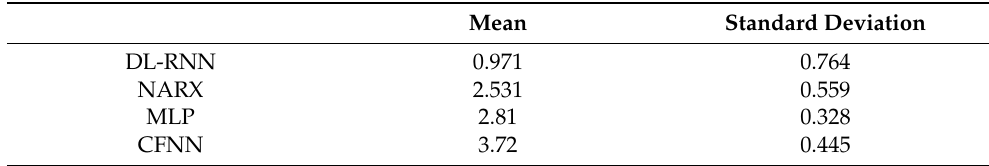
Table 3. Mean and standard deviation of multiple runs.